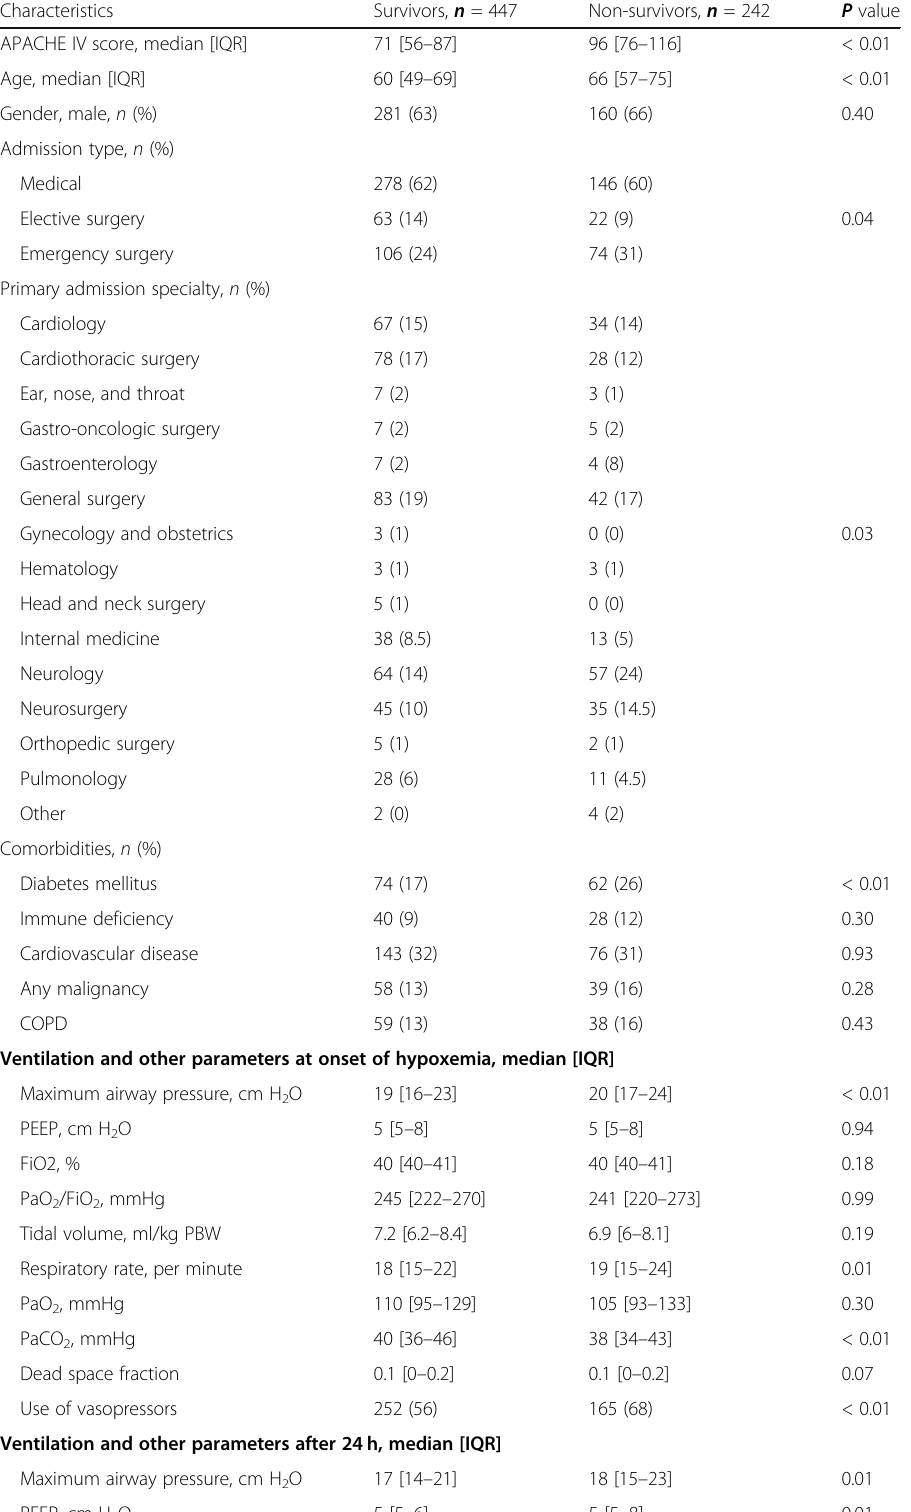
Table 1 Baseline characteristics of patients with mild hypoxemia who survived and patients who died in the hospital Characteristics Survivors, n =